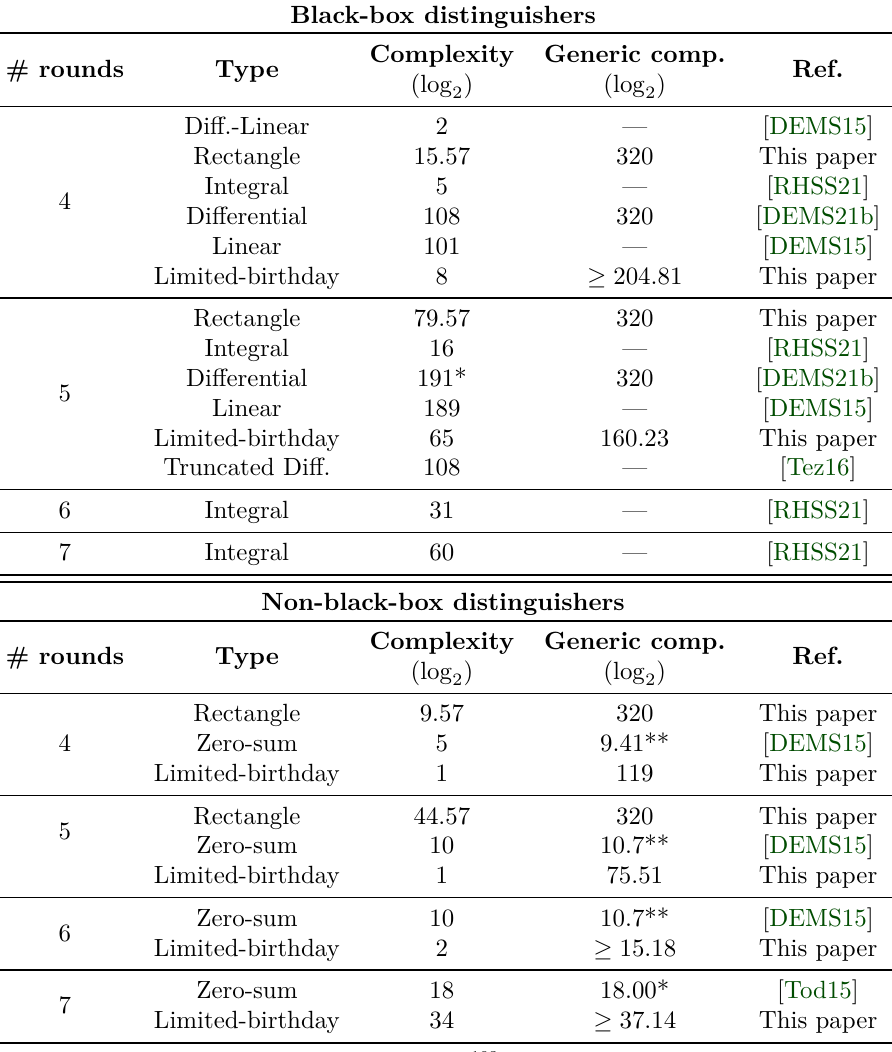
Table 6: Summary of distinguishers against the Ascon permutation. The reported complexities in this table are expressed in terms of the number of primitive calls, which explains some of the small variations one can observe in some numbers when compared to the original